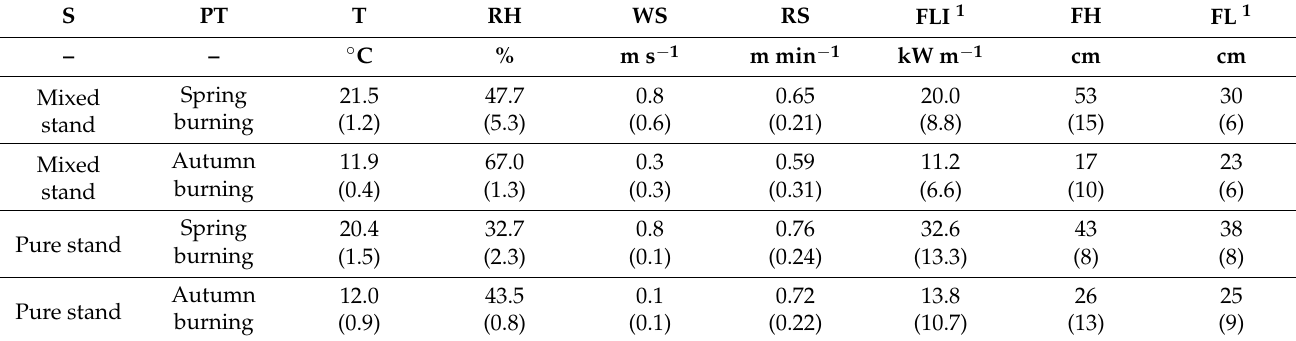
Table 2. Main parameters measured during prescribed burning in mixed and pure stands of P. nigra . Data from [35].